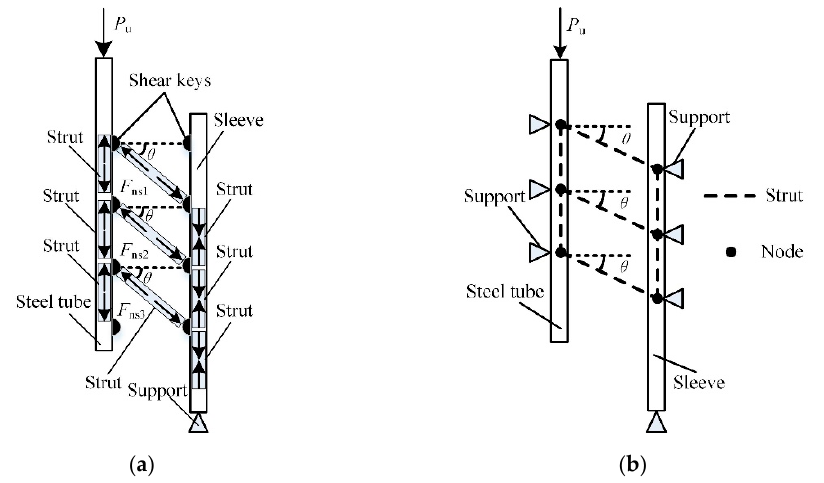
Figure 3. Model of sleeve grouting connection: ( a ) strut-and-tie model; ( b ) simplified mechanical model.